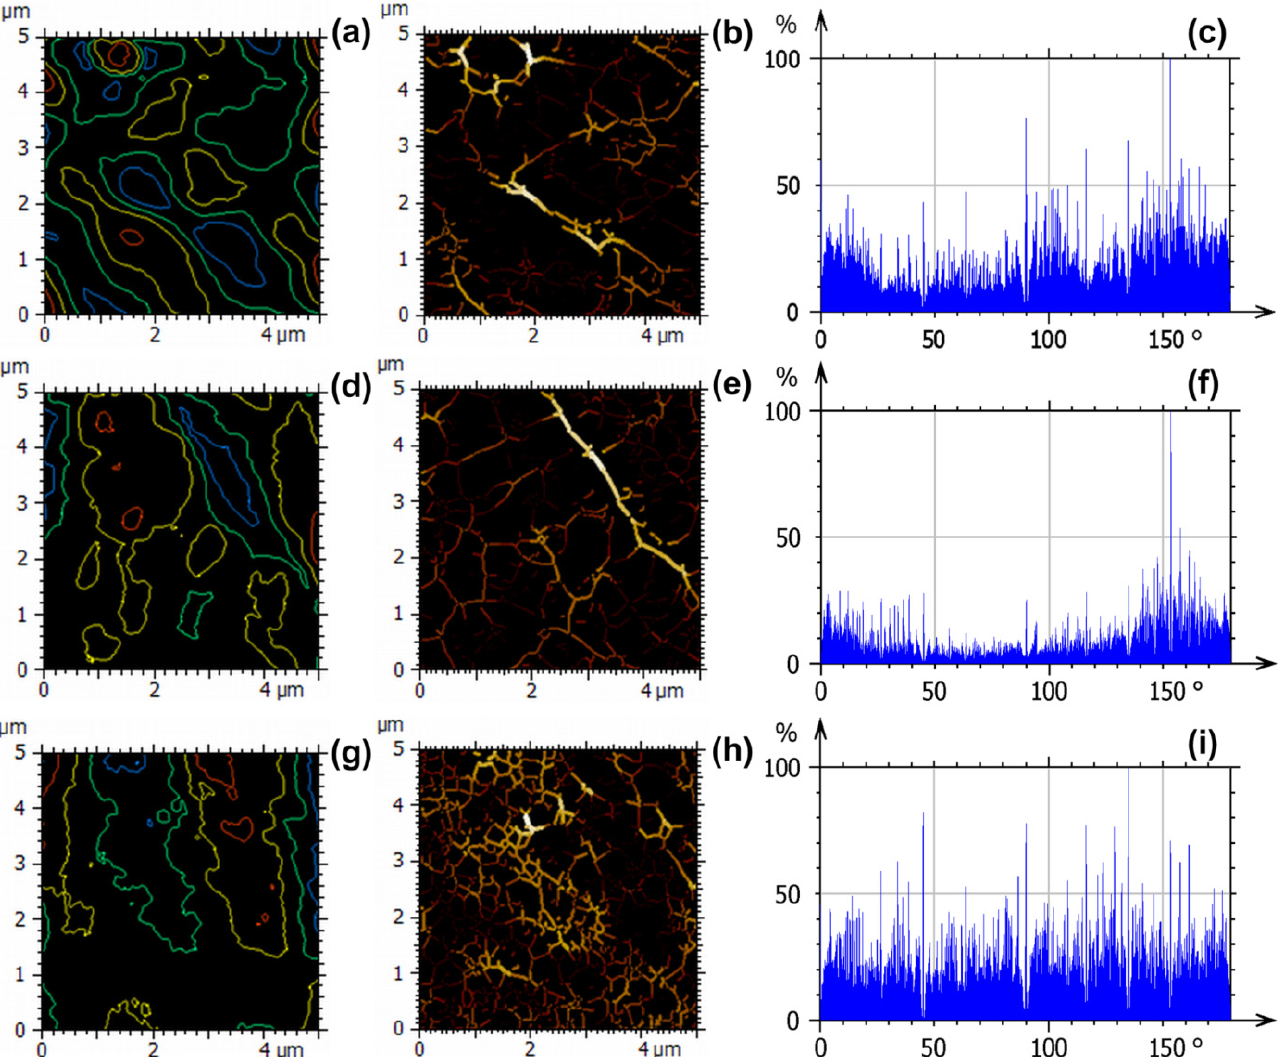
Figure 4. Contour lines ( a , d , g ), furrows ( b , e , h ), and dominant texture directions ( c , f , i ) of ( a – c ) untreated, ( d – f ) HDMSO-treated, and ( g – i ) He/HDMSO-treated TPS films. Table 3. Texture parameters of the untreated and treated starch thin films, according to ISO 25178-2:2012. Parameter Unit Untreated HDMSO MFD